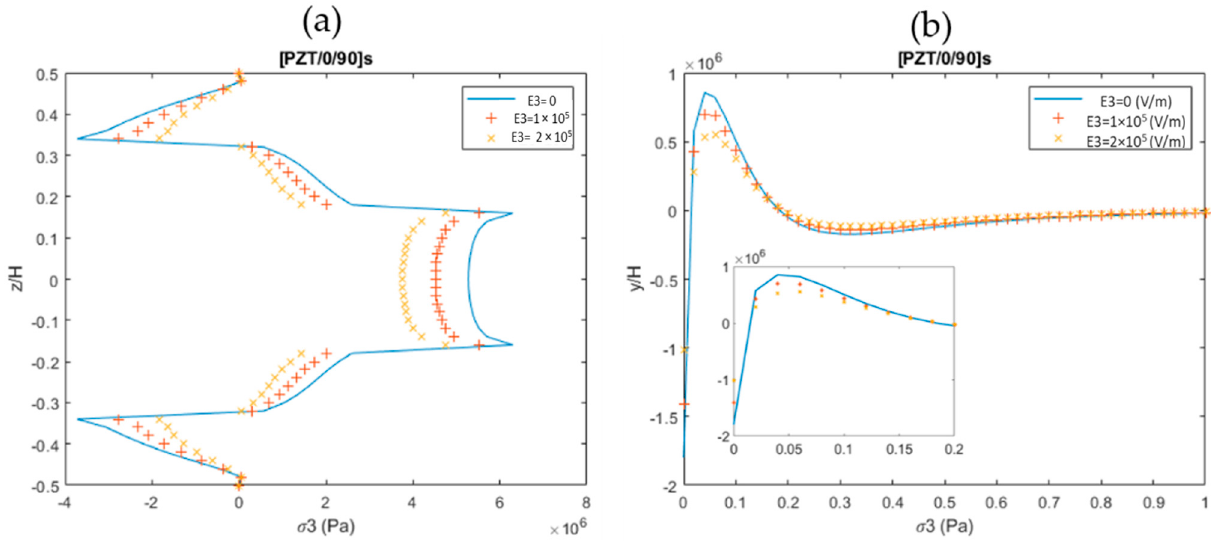
Figure 9. Interlaminar stress σ 3 distribution ( a ) at the free edge and ( b ) at the PZT/0 interface.